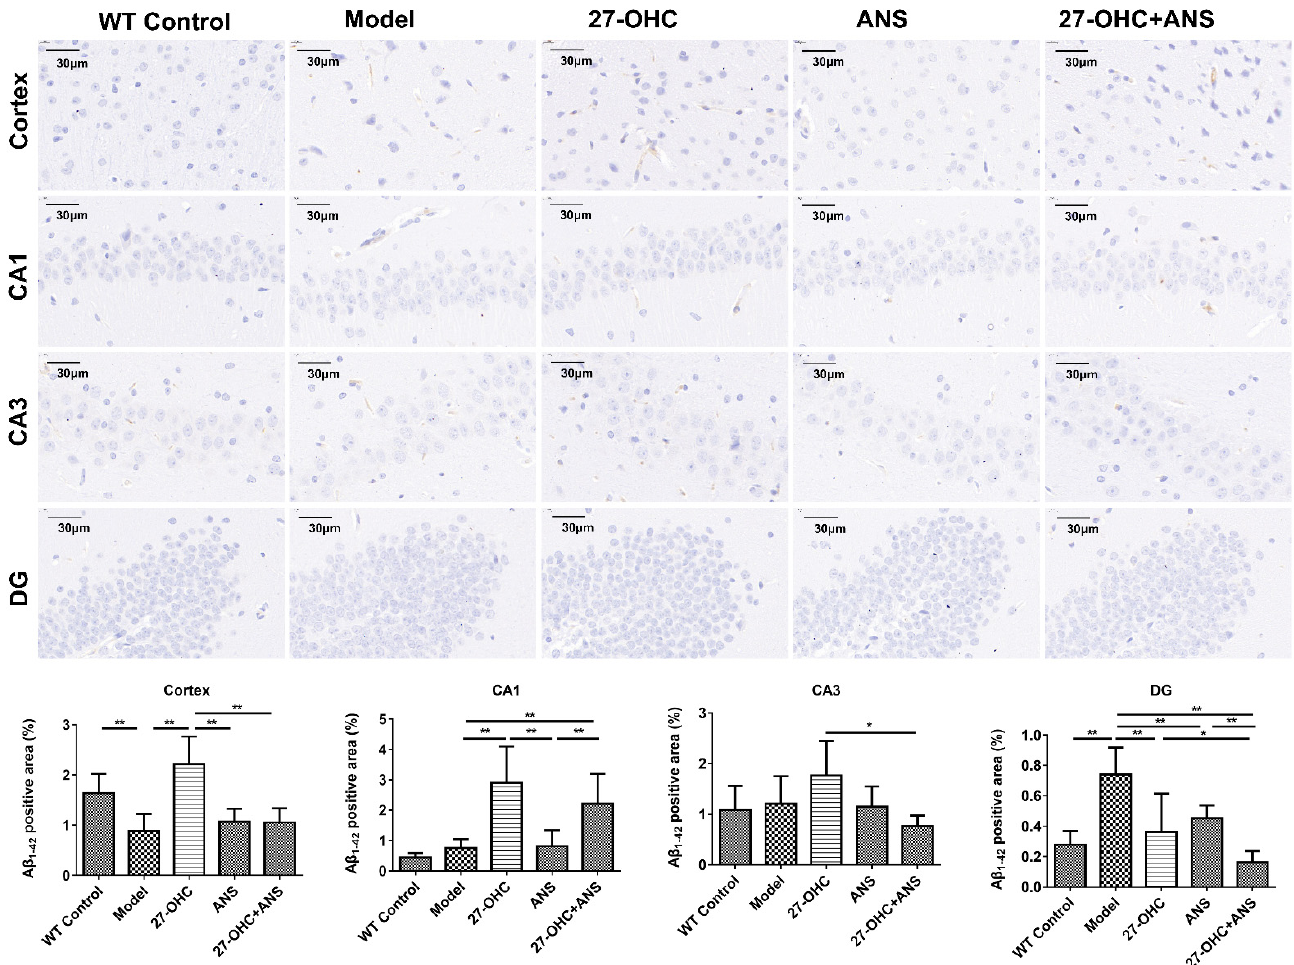
Figure 5. The levels of A β 1-42 in the cortex and hippocampus. Immunohistochemical was performed to assess the levels of A β 1-42 in the cortex, hippocampal CA1, CA3, and DG areas (scale bar = 30 μ m). The A β 1-42 positive area was analyzed using Image J. All data are shown as mean ± SD. * p < 0.05; ** p < 0.01 (one-way ANOVA).